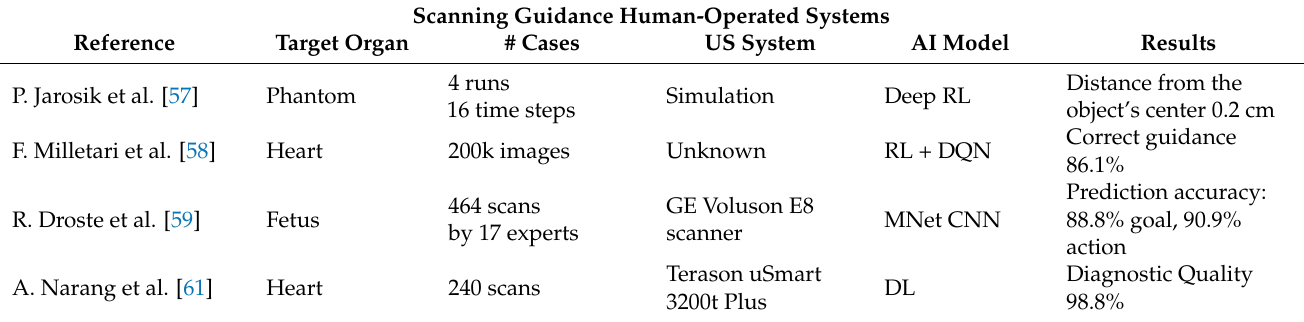
Table 3. Summary of publications on scanning guidance by human-operated systems.